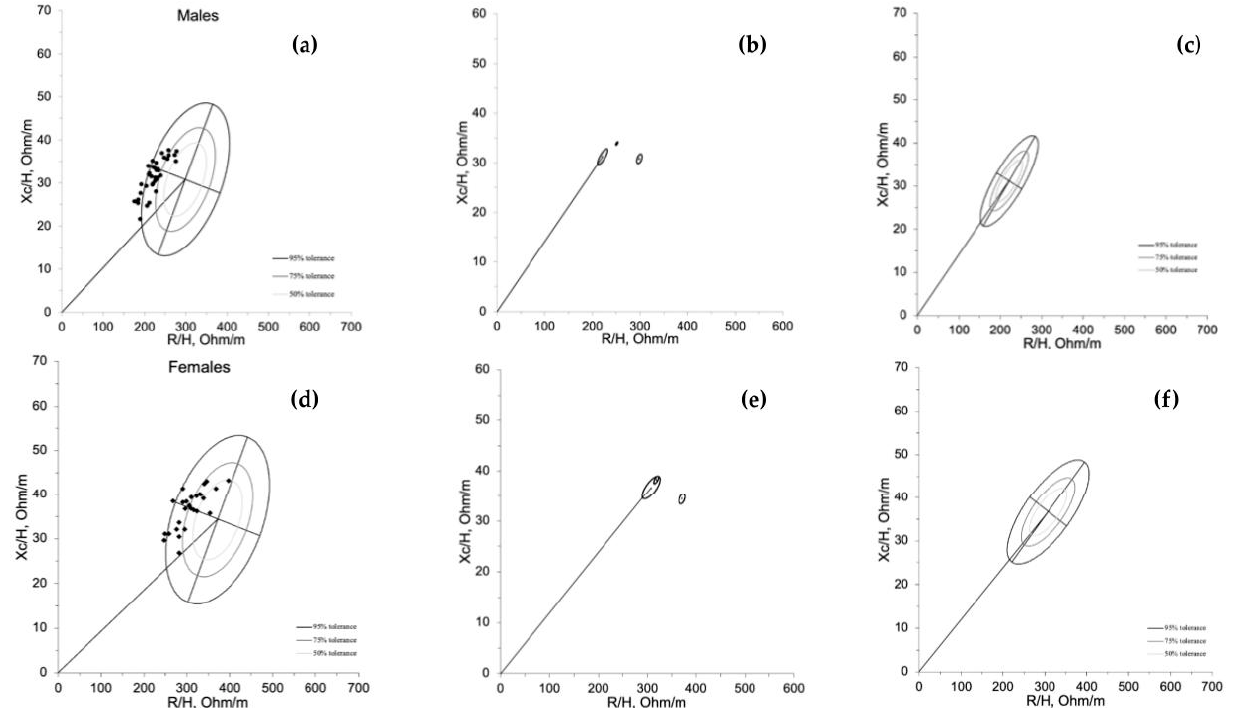
Figure 1. Whole-body BIVA graph of male and female natural bodybuilders. Caption: ( a ) Whole- body BIVA point graph of the male bodybuilders plotted on the tolerance ellipses of the athletic reference. ( b ) Whole-body BIVA mean graph for the whole-body mean impedance vectors of the male bodybuilders and the athletic and general reference population. ( c ) Specific 50%, 75%, and 95% tolerance ellipses of male natural body builders. ( d ) Whole-body BIVA point graph of the female bodybuilders plotted on the tolerance ellipses of the athletic reference. ( e ) Whole-body BIVA mean graph for the whole-body mean impedance vectors of the female bodybuilders and the athletic and general reference population. ( f ) Specific 50%, 75%, and 95% tolerance ellipses of female natural body builders.